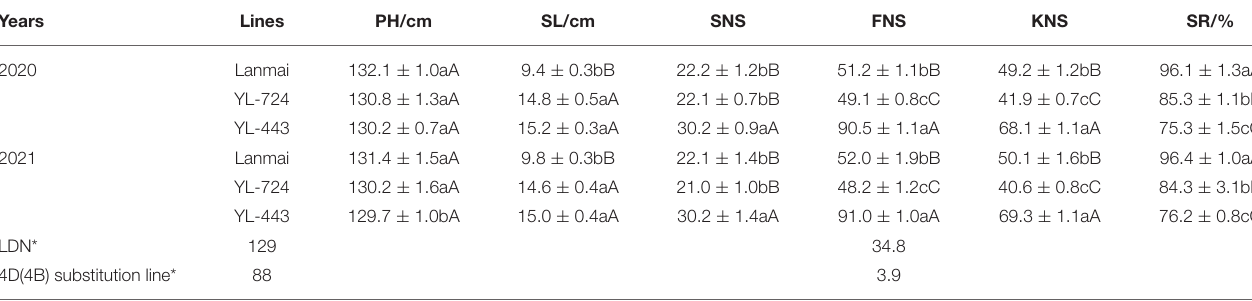
TABLE 1 | Summary of yield component trait. Years